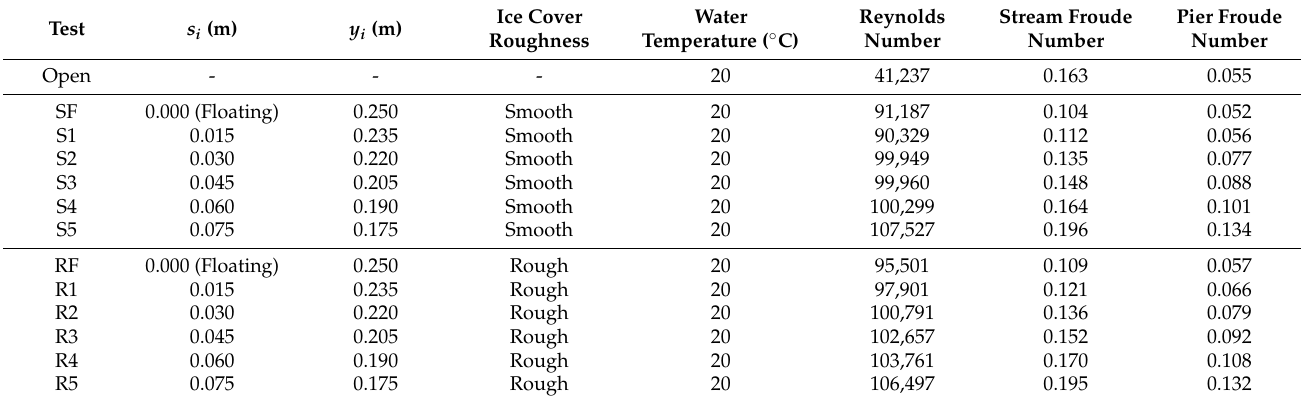
Figure 6. Post-test scanning procedure. Table 1. Experimental